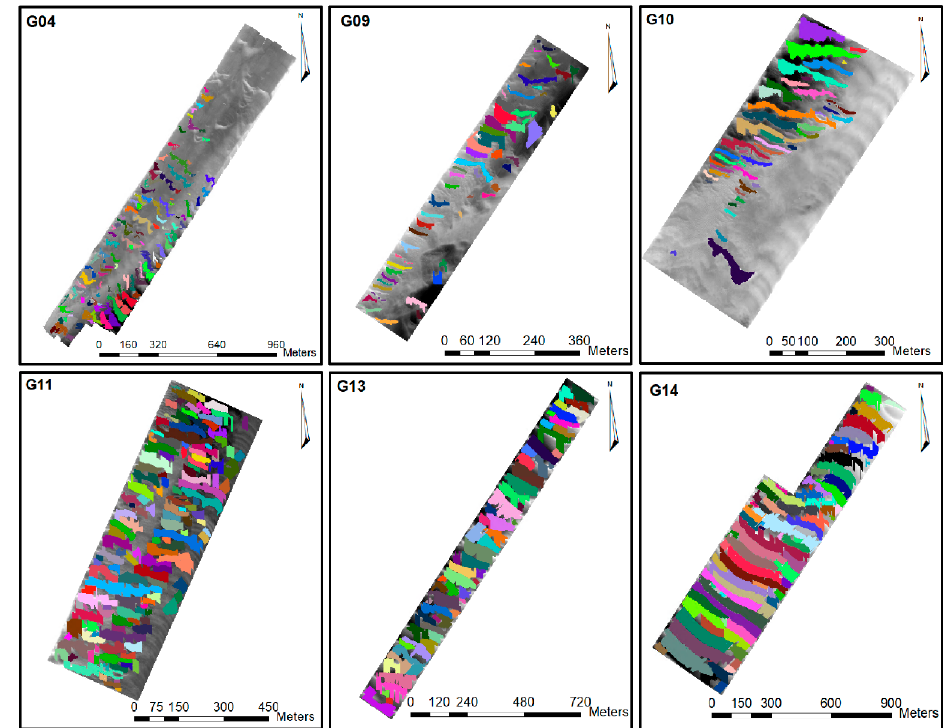
Figure 12. Segmented dunes of the sectors G04, G09, G10, G11, G13, and G14 of the Northern Traverse. The different dune objects are represented by colored polygons. The dune objects are superimposed on the DBM.